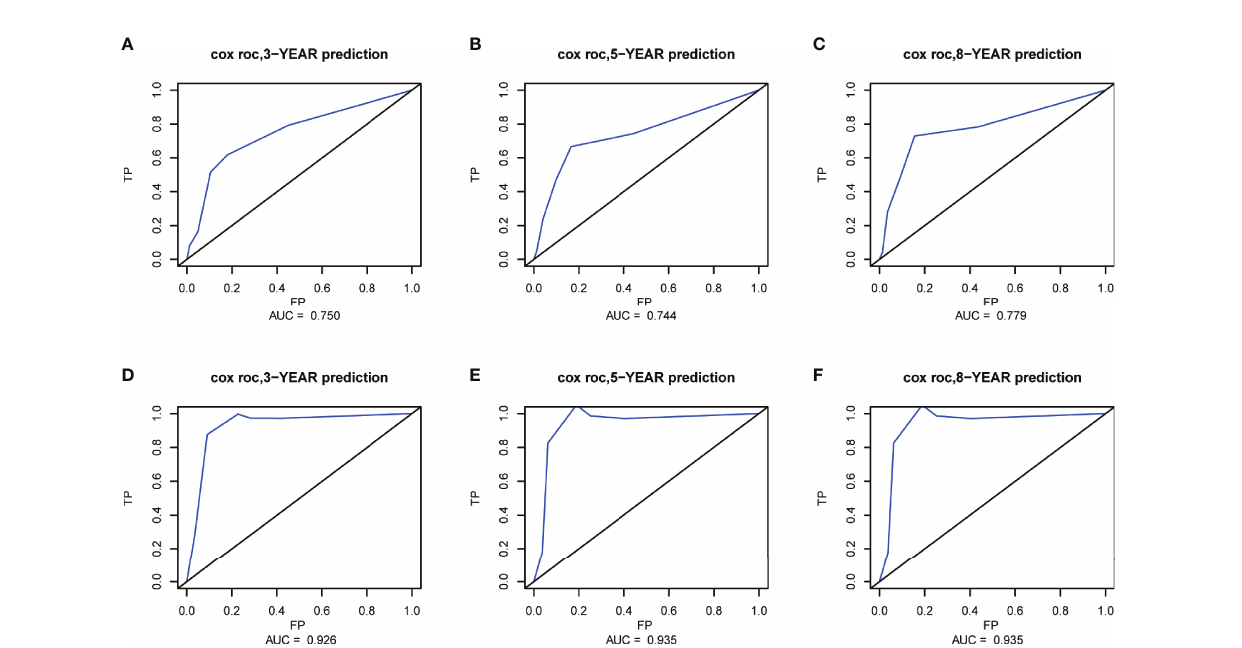
FIGURE 7 | Receiver operating characteristic (ROC) curves at 3, 5, and 8 years in the training set (A – C) and validation set (D – F) for validating the cancer-speci fi c survival (CSS) prediction nomogram.